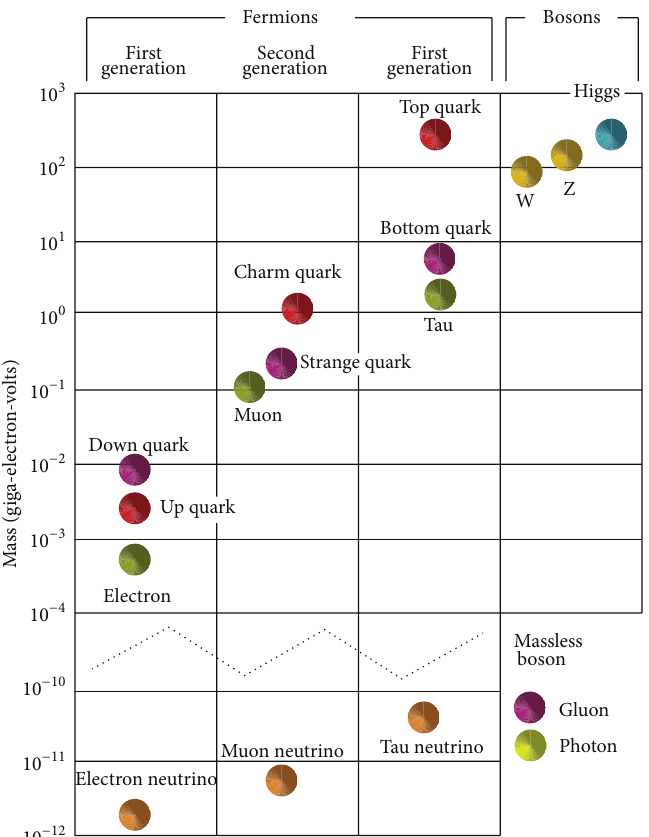
Figure 1: Masses of leptons, of quarks, and of the Higgs boson and neutrino mass splittings in the solar and atmospheric sectors. The dots for ] masses indicate mass upper limits. ∑ 3 1 𝑚 ] ≃ 0.3 eV gives the upper limit on the sum of neutrino masses from cosmological observations (see text).